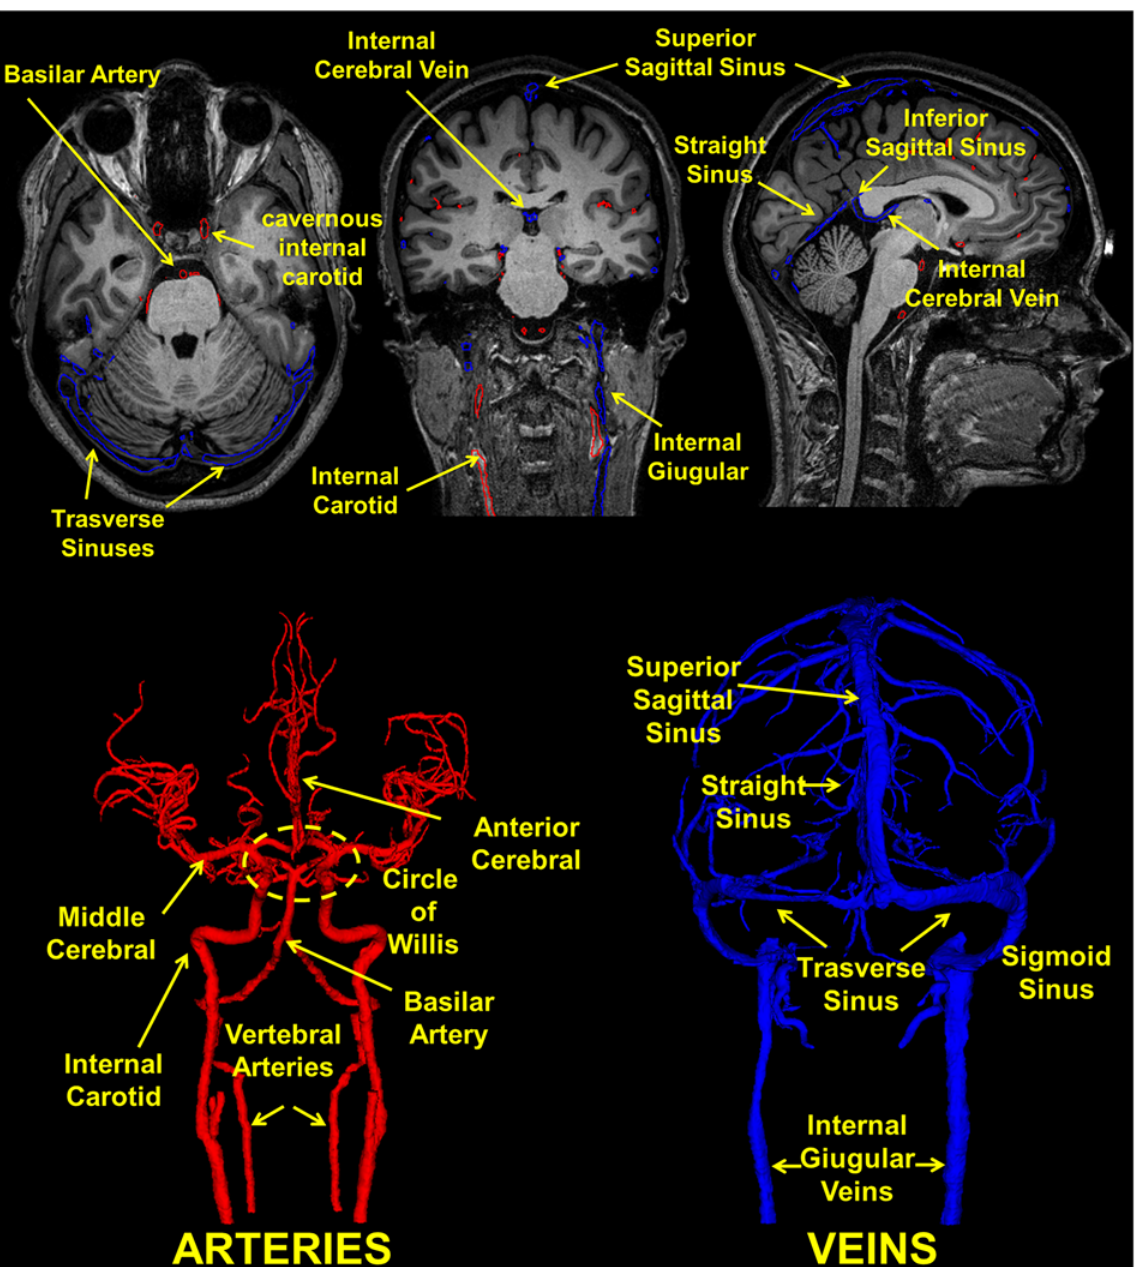
Fig 18. Segmentation of the vasculature. (Top) T1 weighted axial, coronal and sagittal view with the outline of the arteries (red) and veins (blue) and (Bottom) 3D reconstruction of the vessels. The arrows highlight the anterior and middle cerebral arteries, the basilar artery and the internal carotid which converge at the center to form the circle of Willis that supplies blood to the brain. Furthermore, the major veins are shown, including the dural venous sinuses running within the layers of the dura